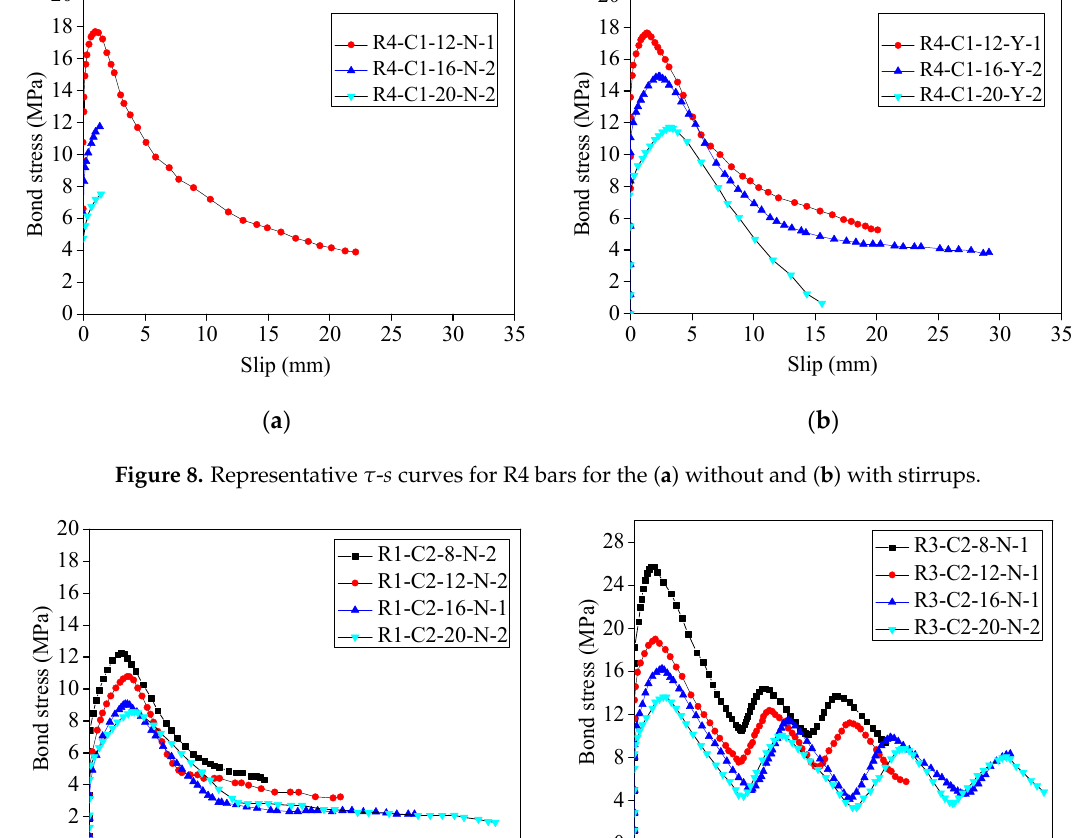
Figure 7. Representative τ - s curves for R3 bars for the ( a ) without and ( b ) with stirrups.